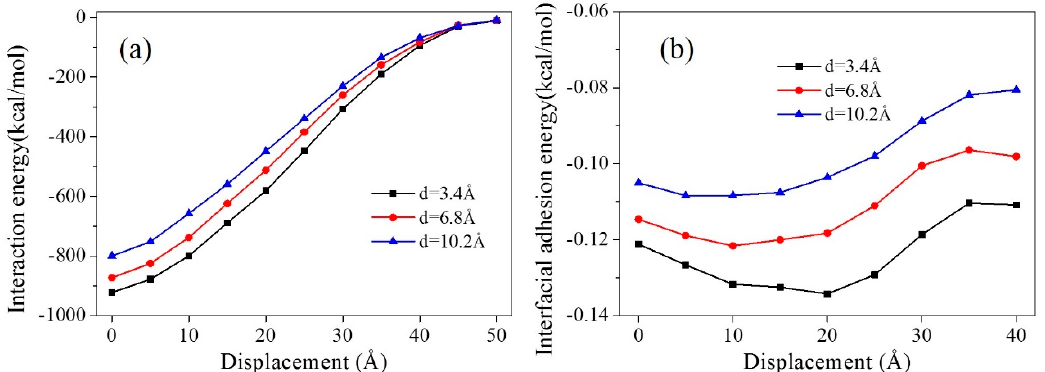
Figure 8. Interaction energies and interfacial adhesion energies for composite models with different distances between the CNT and graphene during the pullout process.